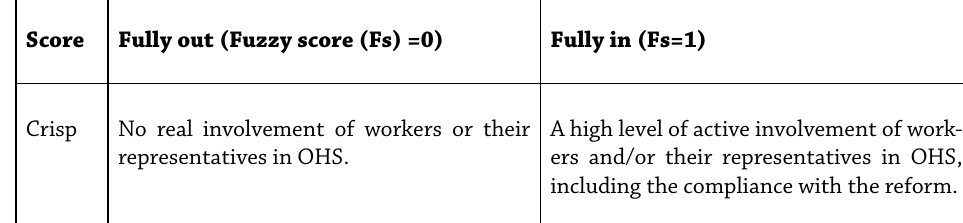
Crisp No real involvement of workers or